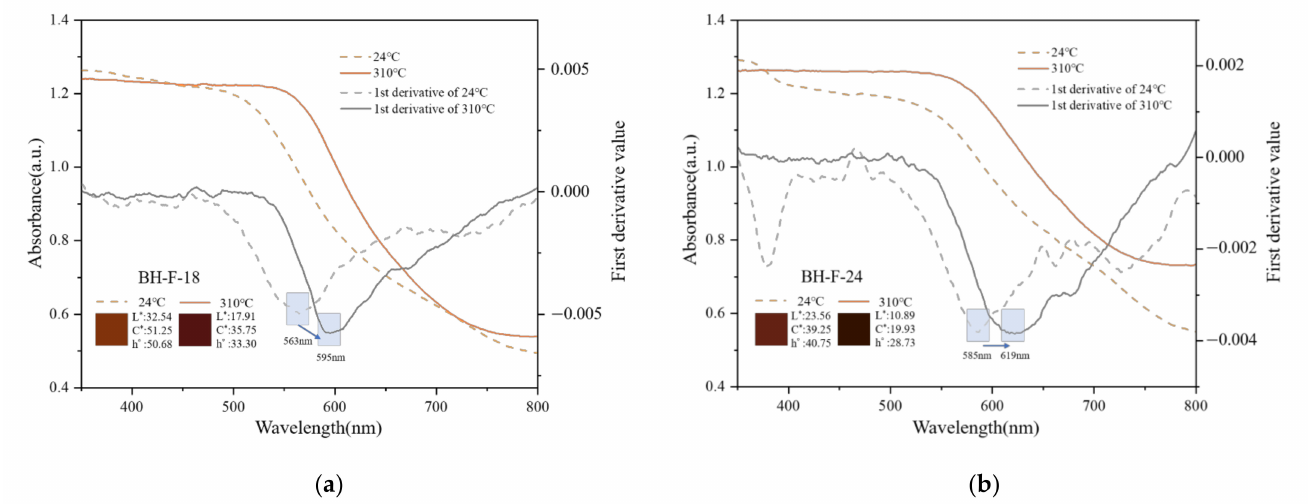
Figure 11. Comparison of the UV-VIS spectra and the first derivative curves before and after heat treatment of samples named BH-F-18 ( a ) and named BH-F-24 ( b ). The curves of UV-UIS spectra and first derivative are indicated by yellow and grey, respectively. The primary trough of sample BH-F-18 is not only changing in position but also changes in value, while that of sample BH-F-24 only changes in position, indicating that BH-F-18 contains a higher relative content of